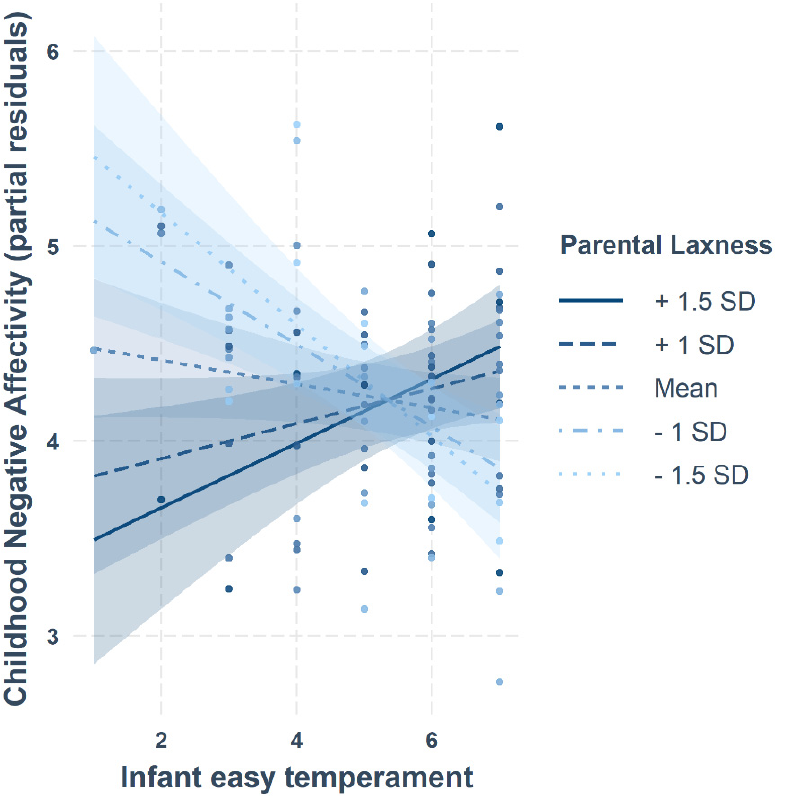
Figure 2. Association between easy infant temperament and childhood Negative Affectivity as a function of parental laxness (controlling for difficult temperament, sex, GA at birth, IMD score and age at follow-up assessment).